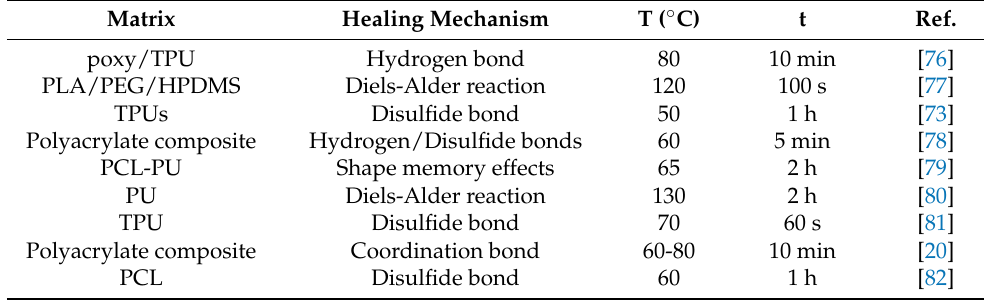
Table 2. Thermally triggered self-healing polymers based on different dynamic interactions. Matrix Healing